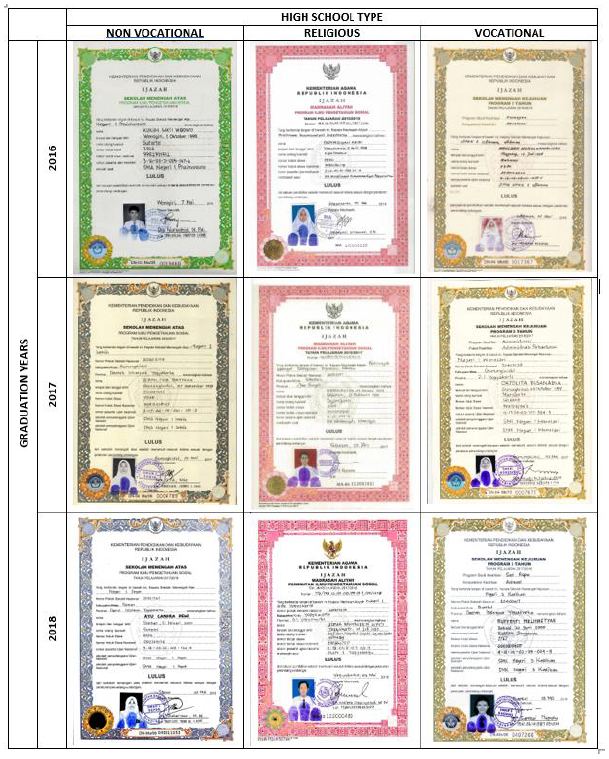
Fig. 1. Image examples from each class in the dataset